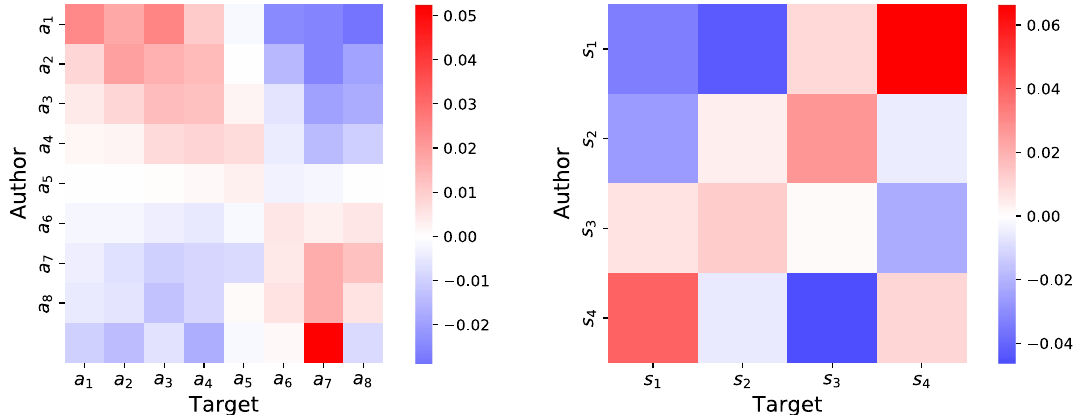
Figure 3. Difference between empirical and random conditional probabilities in the Politics network with respect to activity classes (on the left, with a 1 being the least active users) and to score classes (on the right, with s 1 being the lowest scores). We observe assortative behavior with respect to activity (higher values on diagonal) and disassortative behavior with respect to score (higher values off